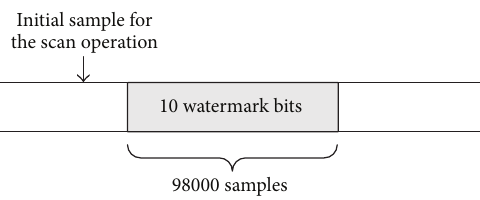
Figure 19: The initial sample, which is before the watermarked segment, is randomly chosen for the scan